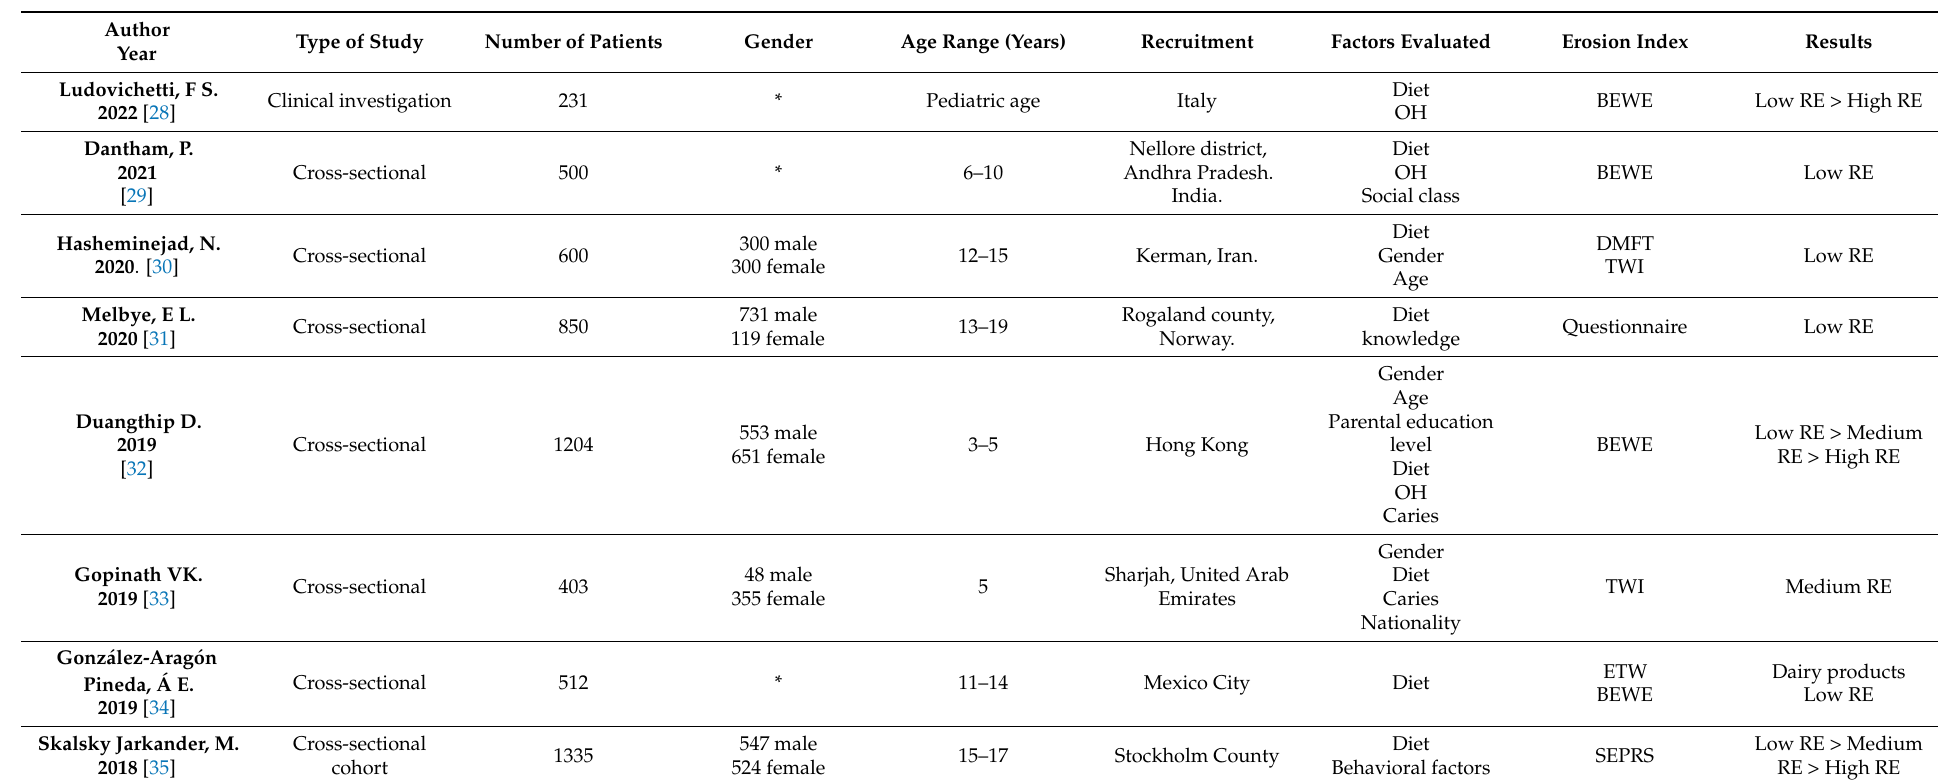
Table 1. Summary of